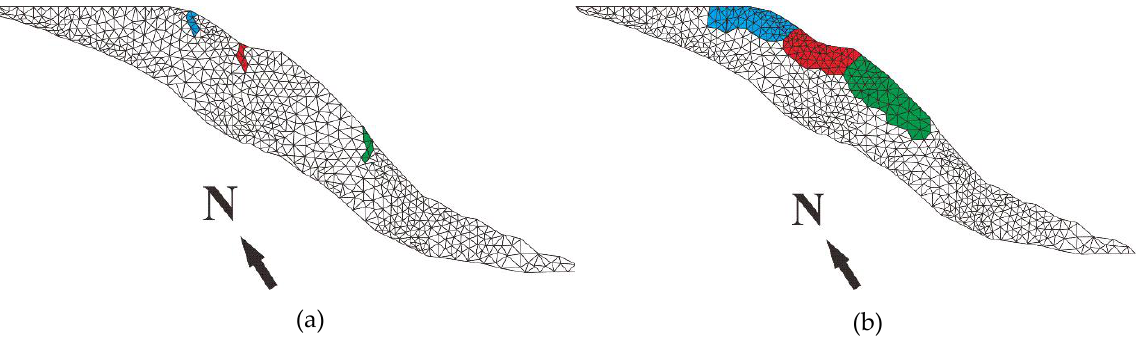
Figure 5. The division area of the slope morphology under two conditions: ( a ) point scale (33°); ( b ) surface scale.